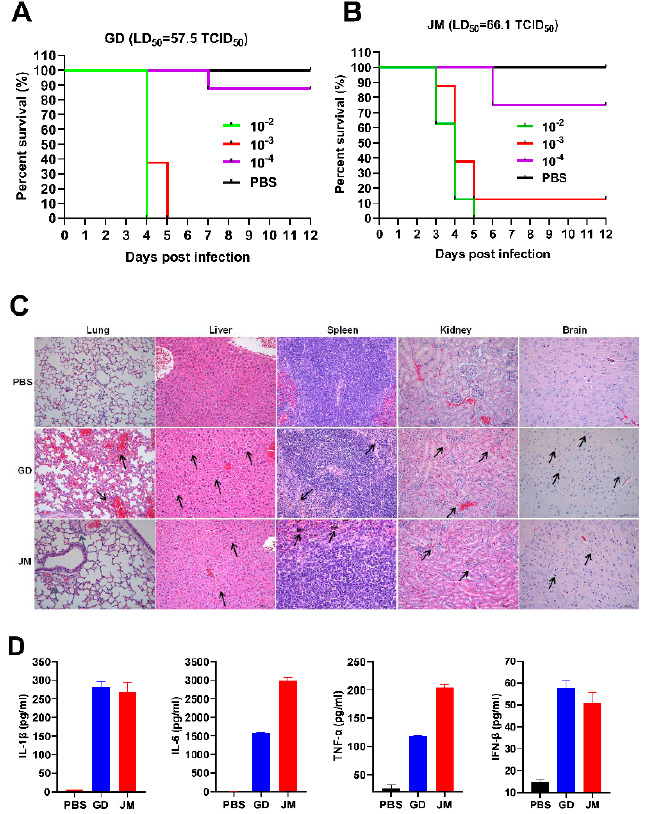
Figure 5. The pathogenicity and the immune responses of PRV-GD and PRV-JM in experimental mice. ( A , B ), LD 50 of the PRV-GD ( A ) and PRV-JM ( B ) to six − week − old C57BL/6J mice. ( C ), Pathological lesions of mice (H&E staining, black arrow) that died following experimental infection with PRV-GD and PRV-JM isolates. ( D ), Detection of the protein levels of IL-1 β , IL-6, TNF- α and IFN- β in serum challenged by PRV-GD and PRV-JM isolates.